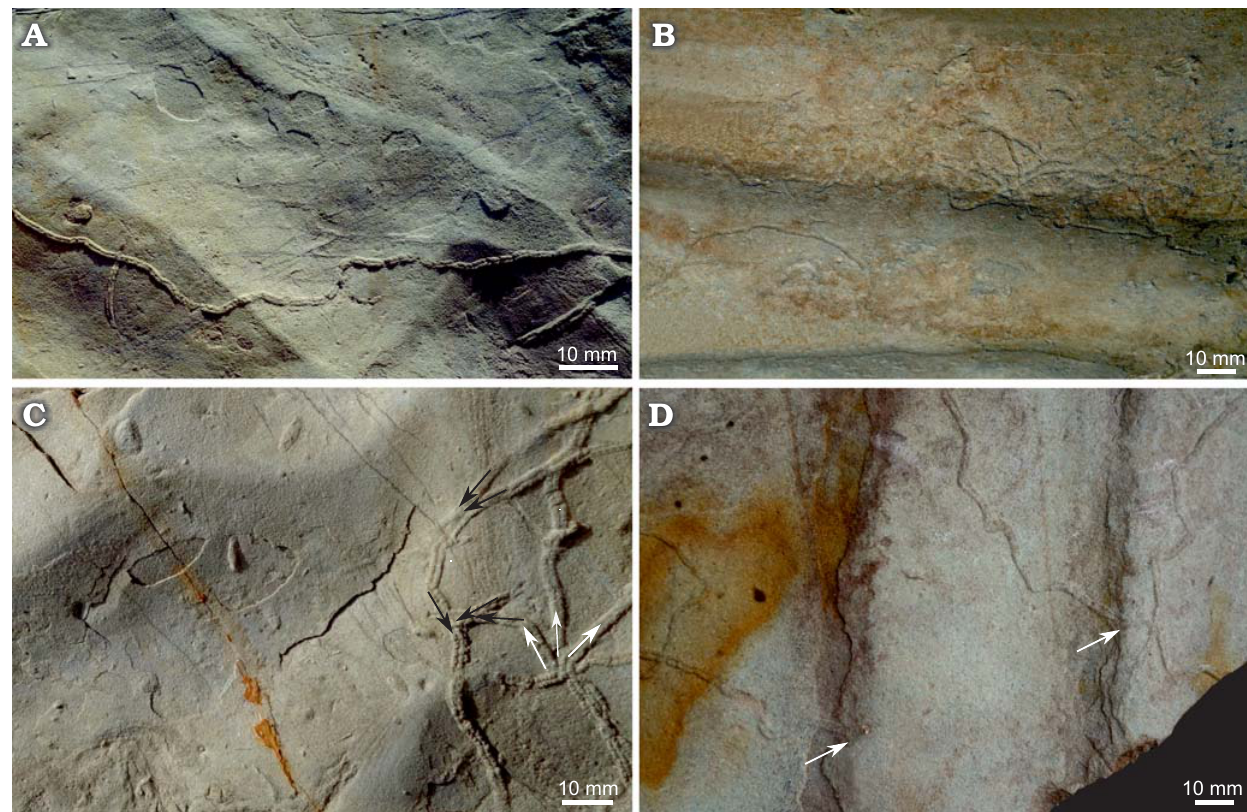
Fig. 3. Trace fossil Gyrochorte comosa Heer, 1865 on bed surfaces structured by wave ripples; Mulichinco Formation, Lower Cretaceous, Puerto Curaco, Neuquén Province, Argentina (field photographs). A . Gyrochorte comosa on bed surface exhibiting parallel-crested, symmetric ripples. B . Parallel- crested, slightly asymmetric ripples traversed by G. comosa being more frequent at the stoss-side and the crest of the ripples. C . Bed surface structured by interfering symmetric ripples documenting sequorichnial behaviour of G. comosa producers (black arrows, “converging” traces; white arrows, “diverg- ing” traces); note acute angle between diverging or converging traces. D . Bed surface exhibiting parallel-crested, slightly asymmetric ripples; G. comosa is overtopped by sand at the lee side of the ripples (white arrows). All specimens left in the